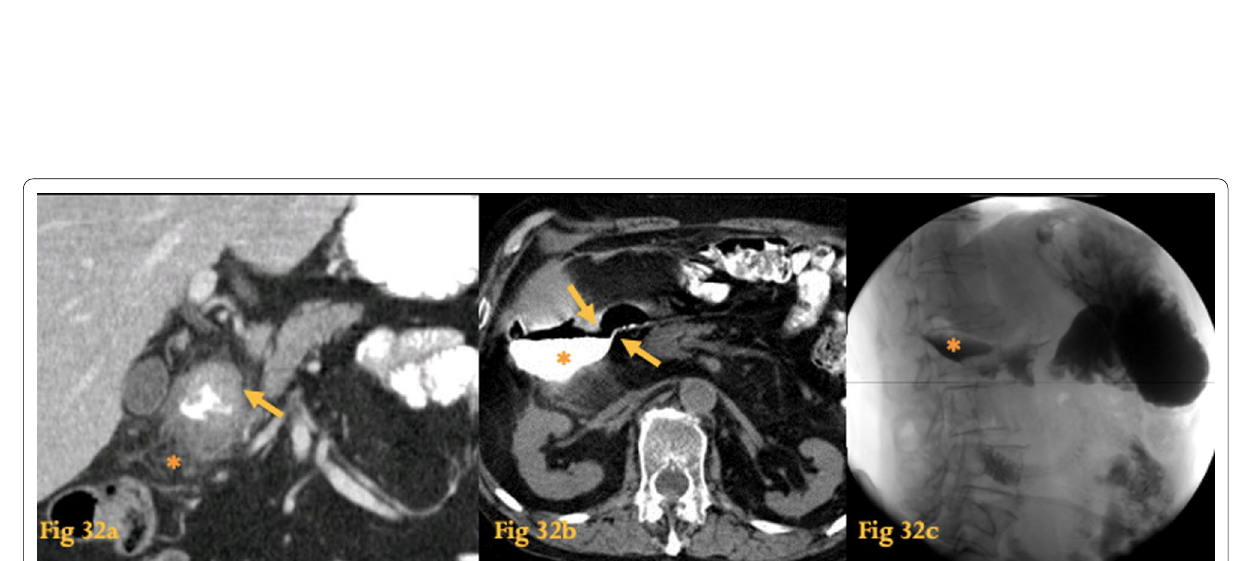
Fig. 32 Ulcers and duodenitis. Abdominal CT of a case of duodenitis ( a ): the lumen of the duodenum is irregular; the wall is thickened (arrow) and there is adjacent fat stranding (asterisk). Plain abdominal CT of another patient ( b ) clearly shows a duodenal ulcer perforation (arrows) and accumulation of gas and oral contrast in the right anterior pararenal space (asterisk). The corresponding upper GI study performed with water‑soluble contrast agent ( c ) shows retroperitoneal leakage of contrast medium